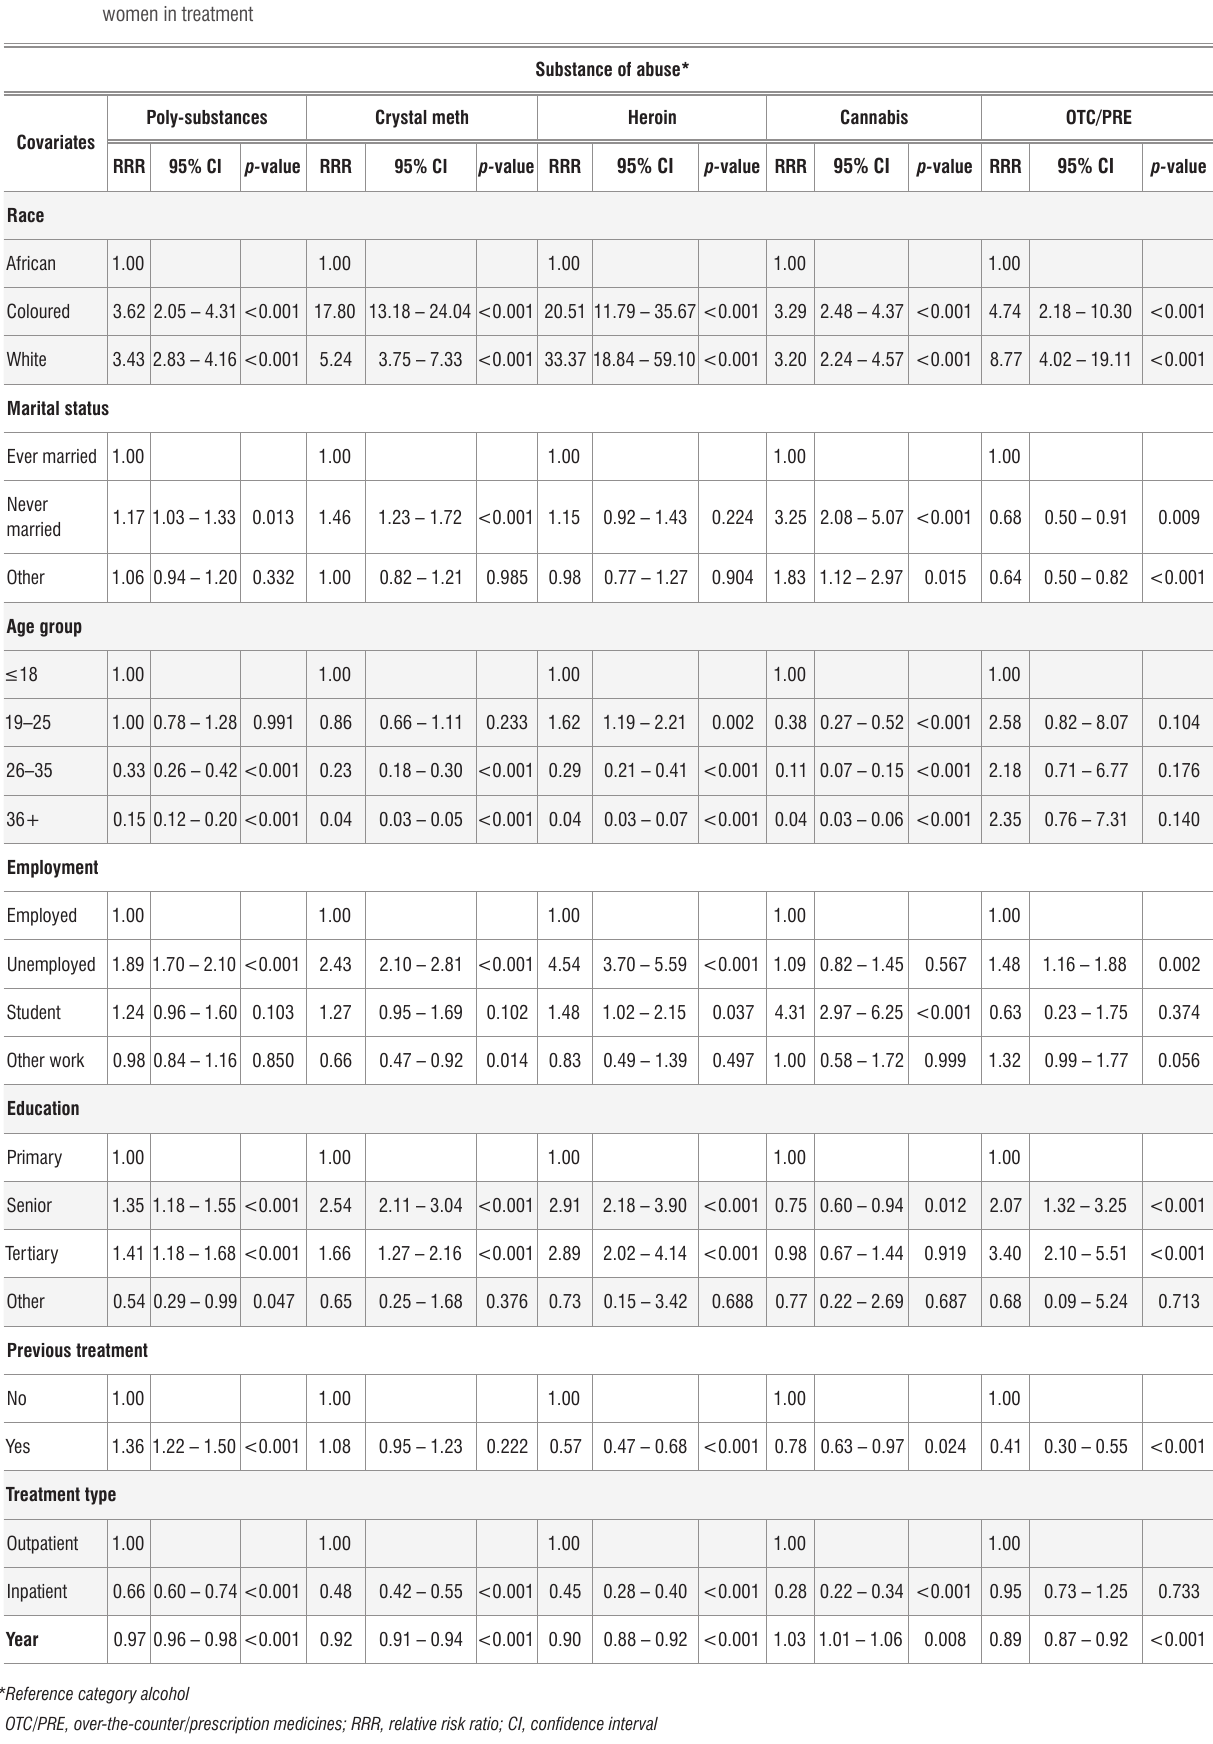
Multinomial logistic regression assessing the association between demographic variables and different primary substances of abuse among women in